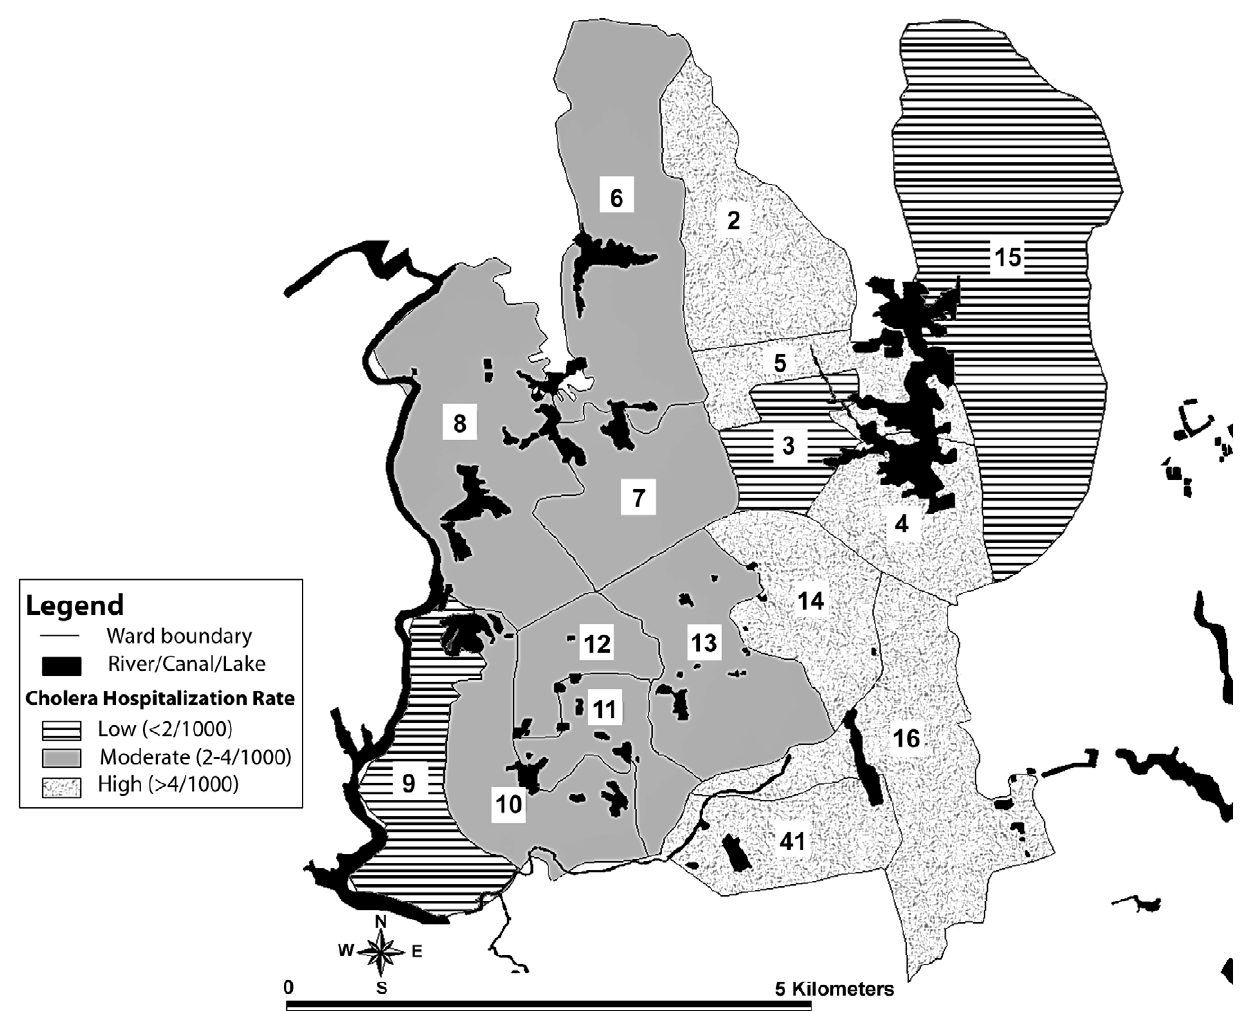
Figure 2. Cholera hospitalization rate (ICDDR, B, Dhaka hospital) from Mirpur area.